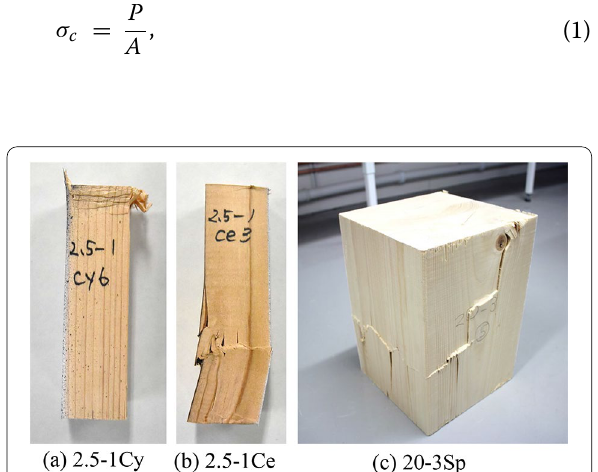
Fig. 6 Typical failure mechanisms: a kink band failure on damage zone, b kink band failure on damage zone and middle zone, c kink band failure on middle zone caused by